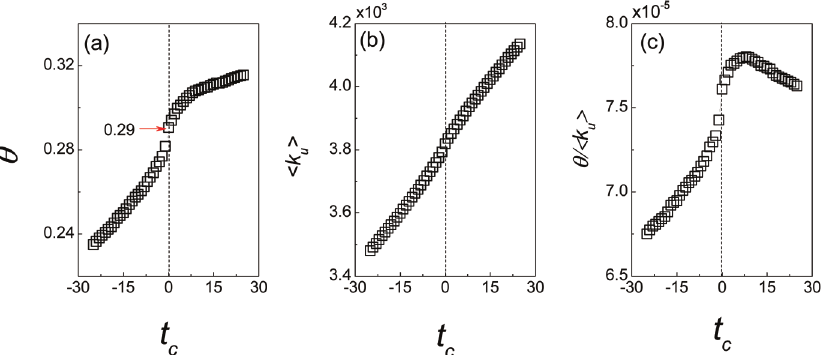
Fig 4. The correlation between the dynamics of the taste similarity θ and the trust formation. The taste similarity θ is quantified by the PCC value of the rating vectors on common interests for a pair of users. (a) The dynamics of the taste similarity θ as the time t c increases. From t c = − 25 to t c = 0, the taste similarity θ rapidly increased from 0.2350 to 0.2906. Then the taste similarity θ only increases by 0.0249 from t c = 0 to t c = 25. The comparison of the growth rate of the taste similarity θ before and after the time t c = 0 indicates that, the users ’ similar tastes lead to the creation of trust relation and not the reverse. (b) The average number of the items commented by users as the time t c increases. In Epinions , the average number of the items commented by users, i.e., the average degree of users, h k u i linearly increases as the time t c increases. (c) The dynamics of the ratio θ / h k u i between the taste similarity and the average degree. Before time t c = 0, the ratio θ / h k u i increases rapidly, which means that, the users ’ taste similarity increasingly close despite the number of items they comment increases.